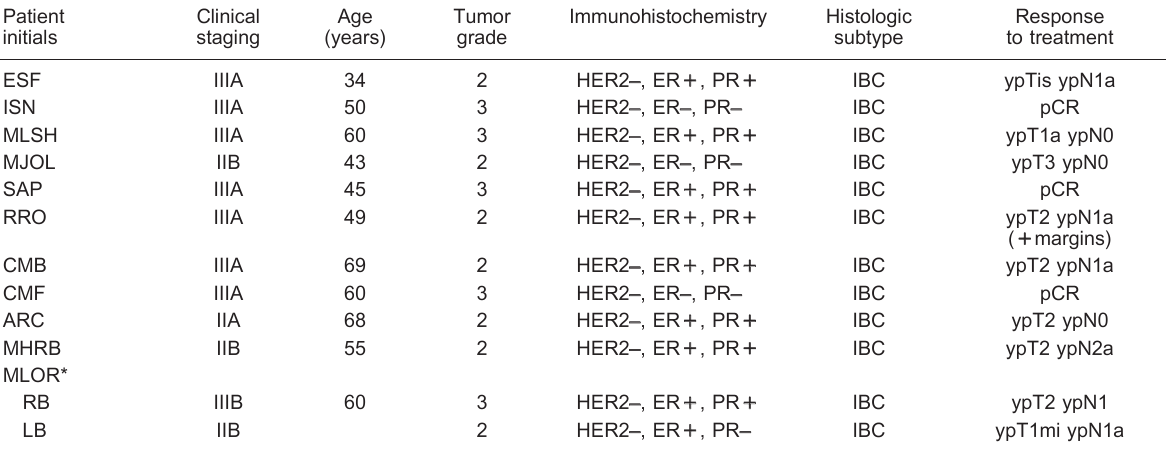
*Bilateral breast cancer. RB: right breast; LB: left breast; pCR: pathological complete response; TNM staging system: primary tumor, lymph node, metastasis; IBC: invasive breast